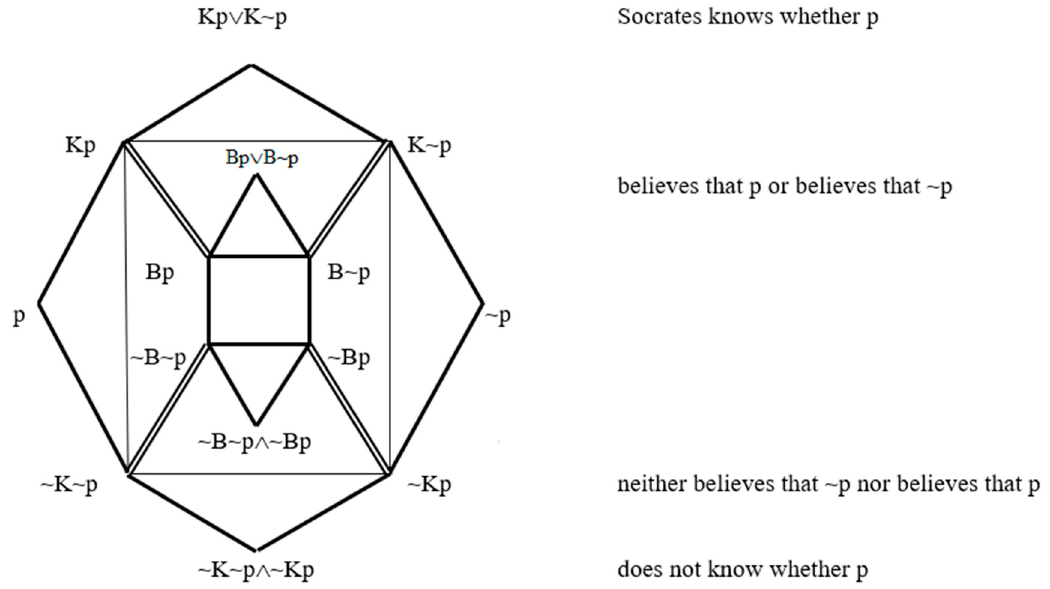
Figure 12. The octagon of knowledge with the hexagon of belief Figure 12. T he octagon of knowledge with the hexagon of belief combined.